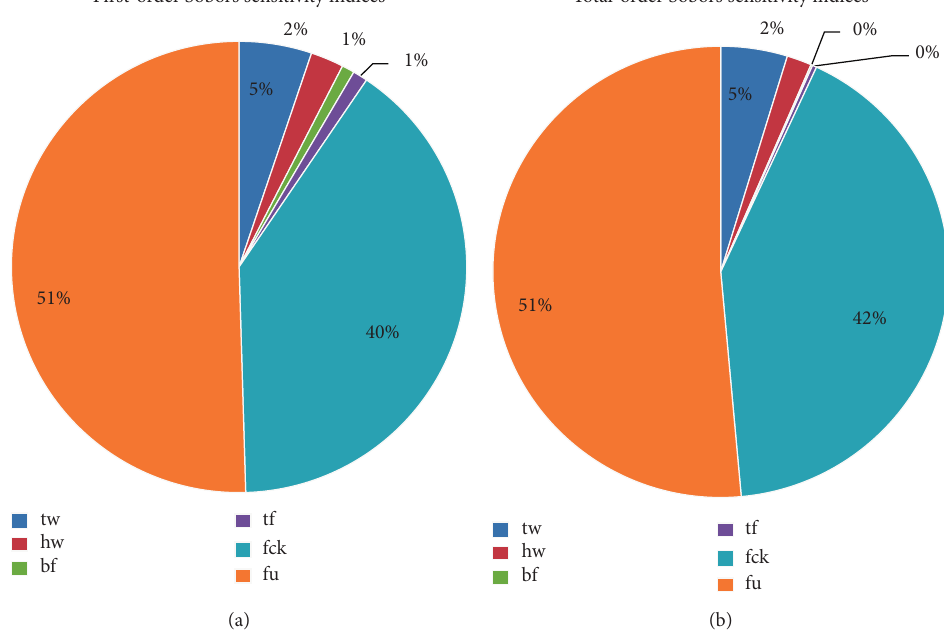
Figure 11: First-order and total Sobol’s sensitivity indices of the 10-year corroded SCC beams.